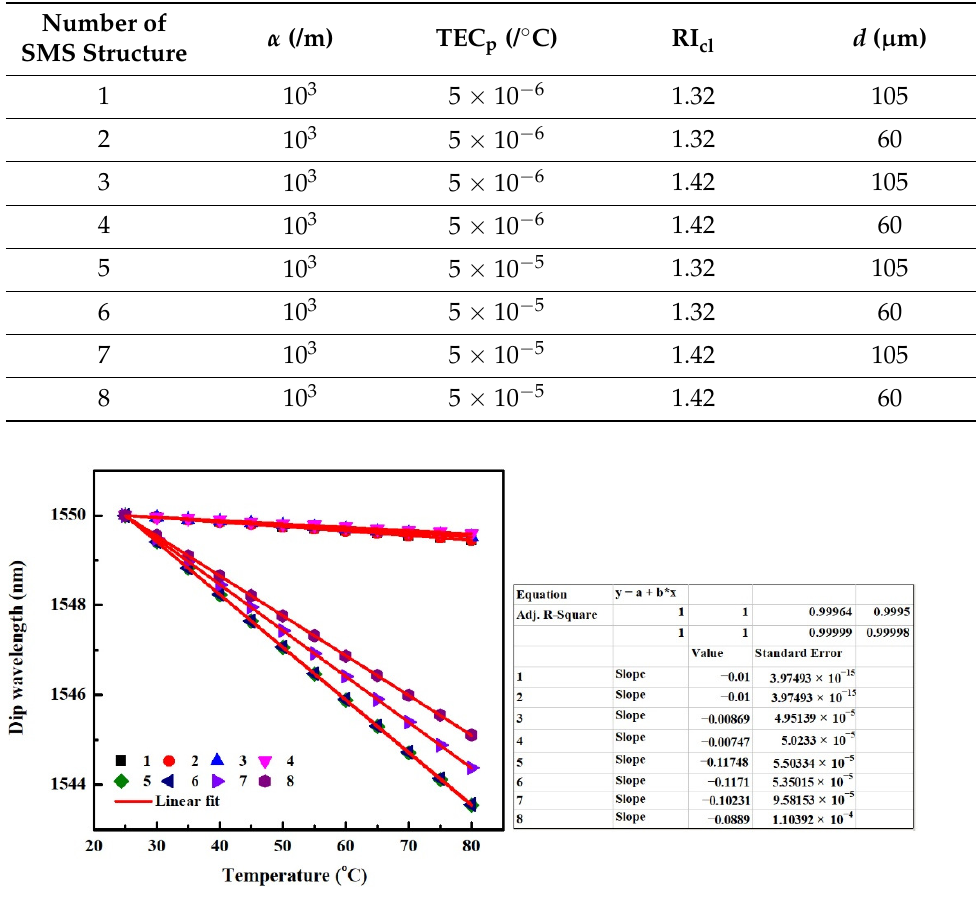
Figure 8. Dip Wavelength as a function of the temperature for SMS fiber structures, only the TEE is taken into account in the simulation.